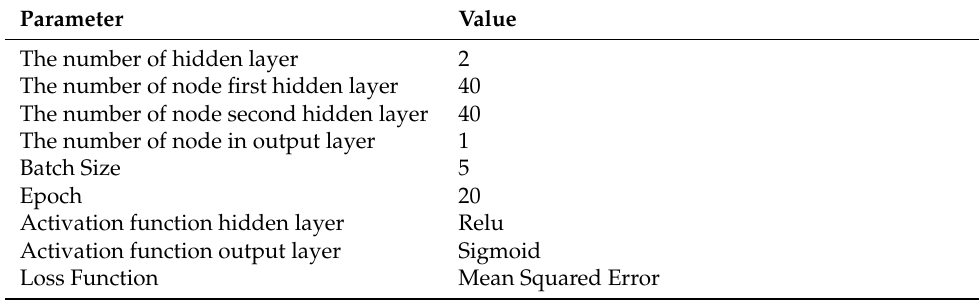
Table 8. The parameters for building ANC on FPGA. Parameter Value